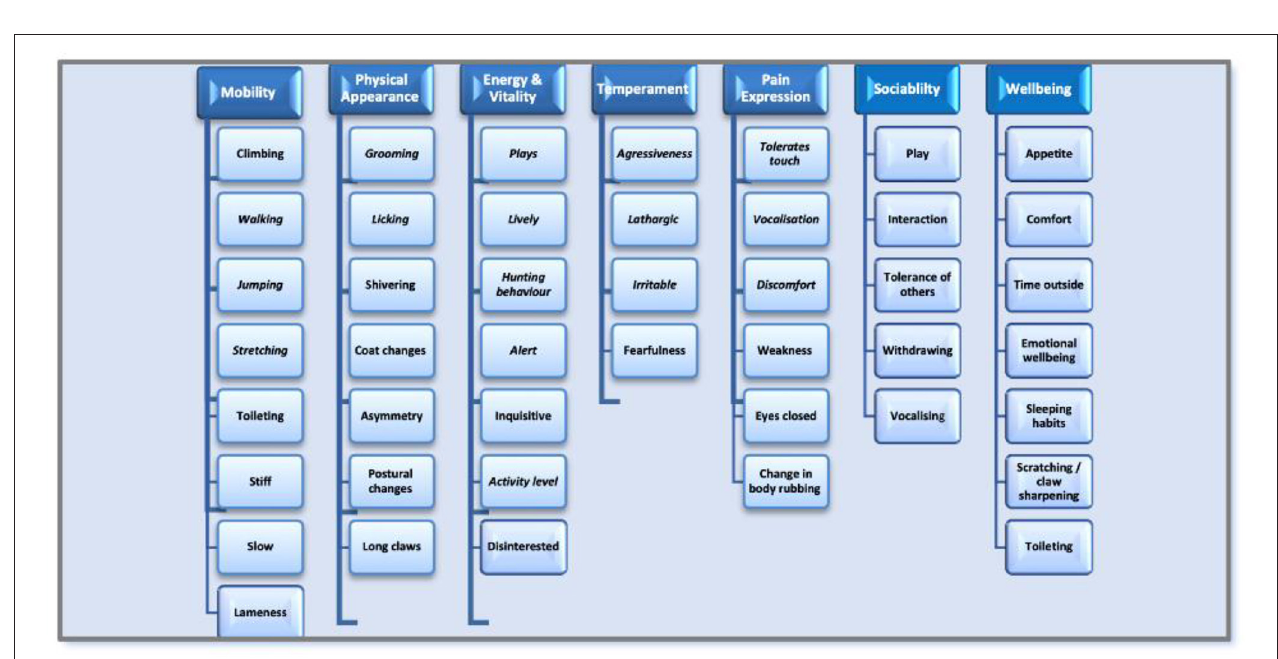
FIGURE 2 | Conceptual framework.